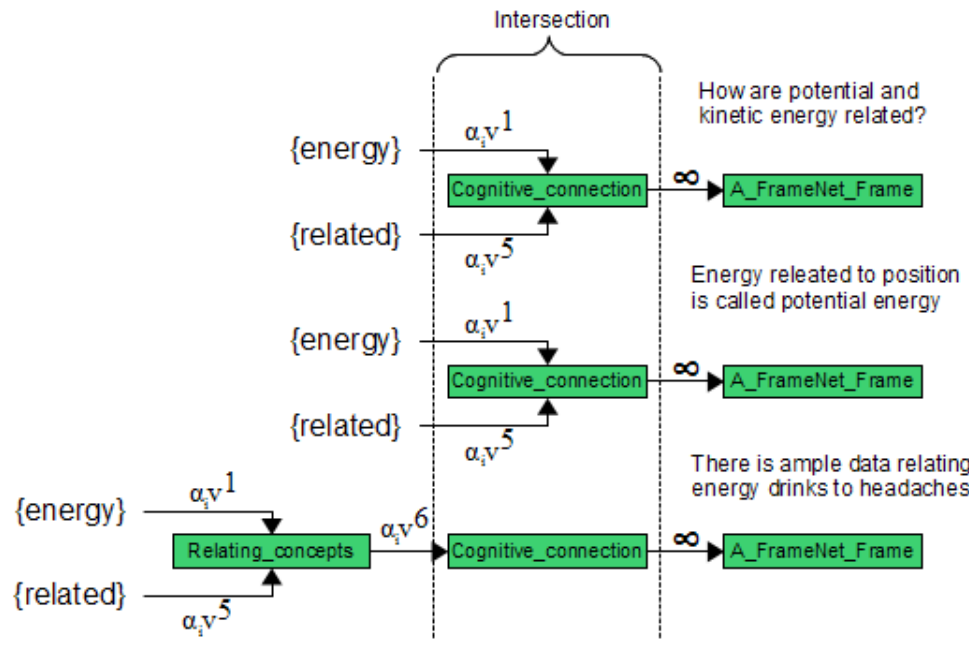
Figure 11 . Paths with assigned edge weights from matching words to the topmost super- frame derived through Figure